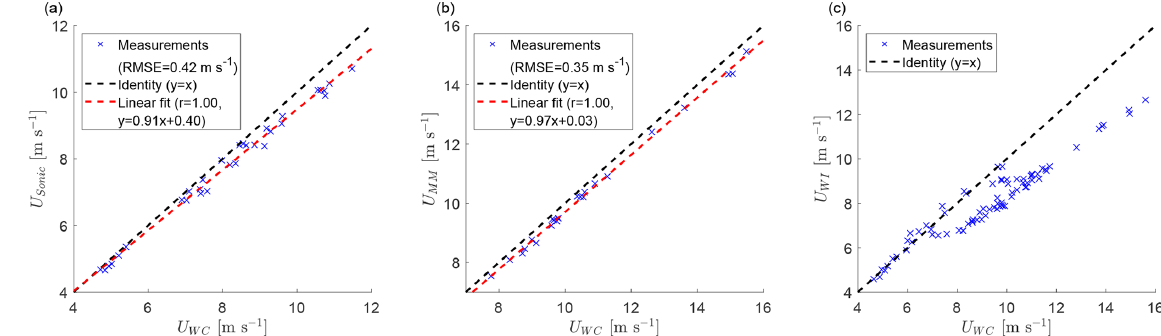
Figure 5. Inter-comparison of the inflow wind speed measurements between the ultrasonic anemometer at 50m and the WindCube at 60m (a) , the meteorological mast at 60m and the WindCube at 60m (b) , and the WindIris and the WindCube at hub height (c) using the wake-steering and the control cases. Measurement data of the ultrasonic anemometer and the cup anemometer were not available for all cases. The dashed black line shows the identity x = y , and a linear fit is shown as a dashed red line together with the correlation coefficient r .